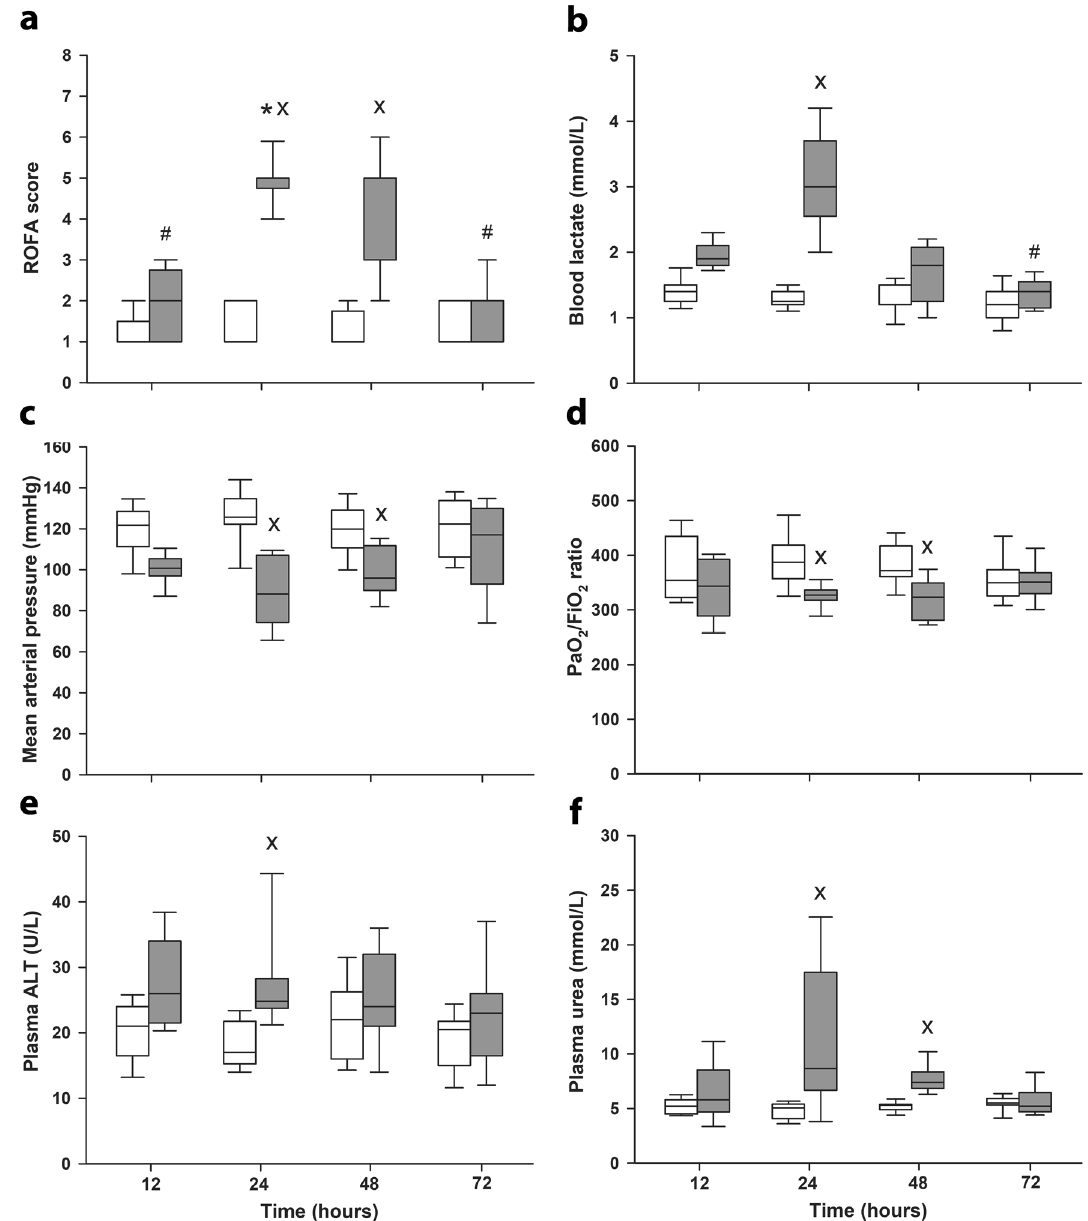
Figure 4. Rat-specific organ failure assessment (ROFA) score and its components in sham-operated animals (n = 12–13, white boxes) and in the different sepsis groups representing different stages of sepsis (grey boxes). Cumulative ROFA score ( a ), plasma lactate levels ( b ), mean arterial pressure ( c ), lung injury (represented by the Carrico index) ( d ), plasma alanine aminotransferase (ALT) ( e ) and plasma urea levels ( f ) are shown. The number of animals used in the various sepsis groups is indicated in Table 1. Comparisons between groups were conducted with the Kruskal–Wallis test followed by Dunn’s post-hoc test. X P < 0.05 vs sham-operated groups; * P < 0.05 vs 12 h sepsis (between sepsis groups); # P < 0.05 vs 24 h sepsis (between sepsis